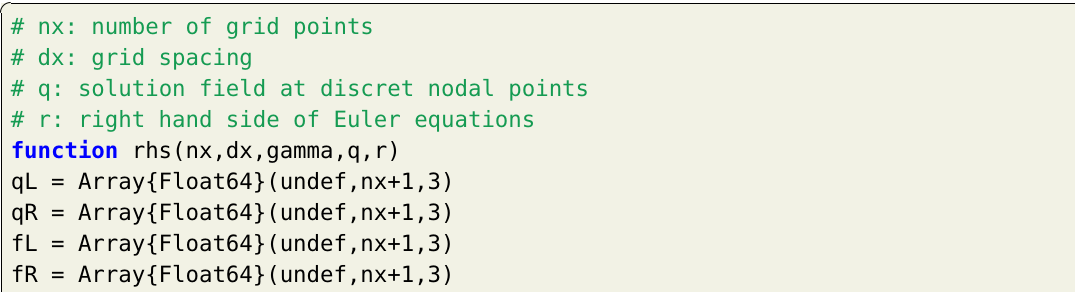
Listing 14. Implementation of Julia function to calculate the right hand side of Euler equations using Roe’s Riemann solver.